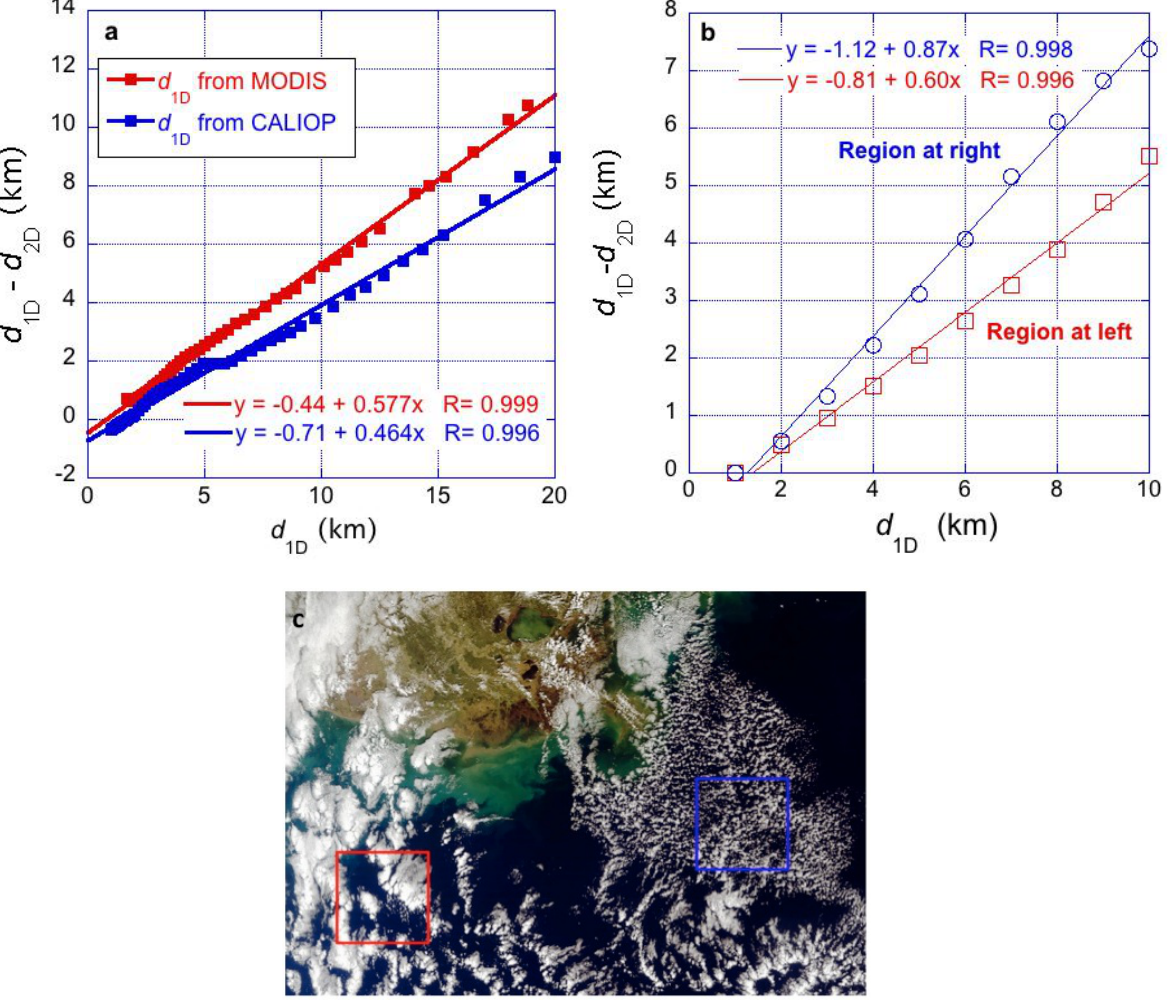
Fig. 4. (a) Relationship between clear areas’ distance to the nearest clouds in 1-D and 2-D searches for clouds, based on the yearlong global dataset. (b) Same relationship for the two sample areas in (c) , with the difference that d 1D and d 2D are obtained directly from the 2-D MODIS cloud mask (without considering lidar color ratios as in a ). For each d 1D bin, median values of d 1D − d 2D are plotted. (c) MODIS image of the Mississippi delta, with the two 100km by 100km size sample areas highlighted. The image was taken by the MODIS instrument on the Terra satellite on 22 November 2003, at